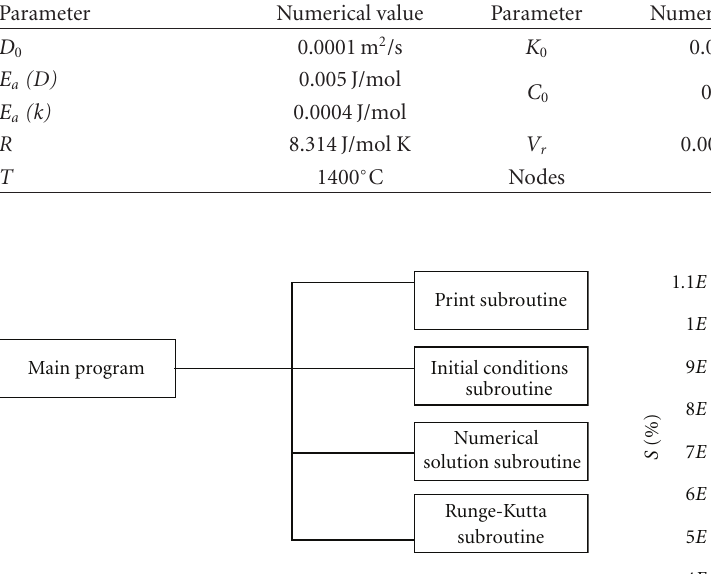
Figure 1: Numerical solution scheme.